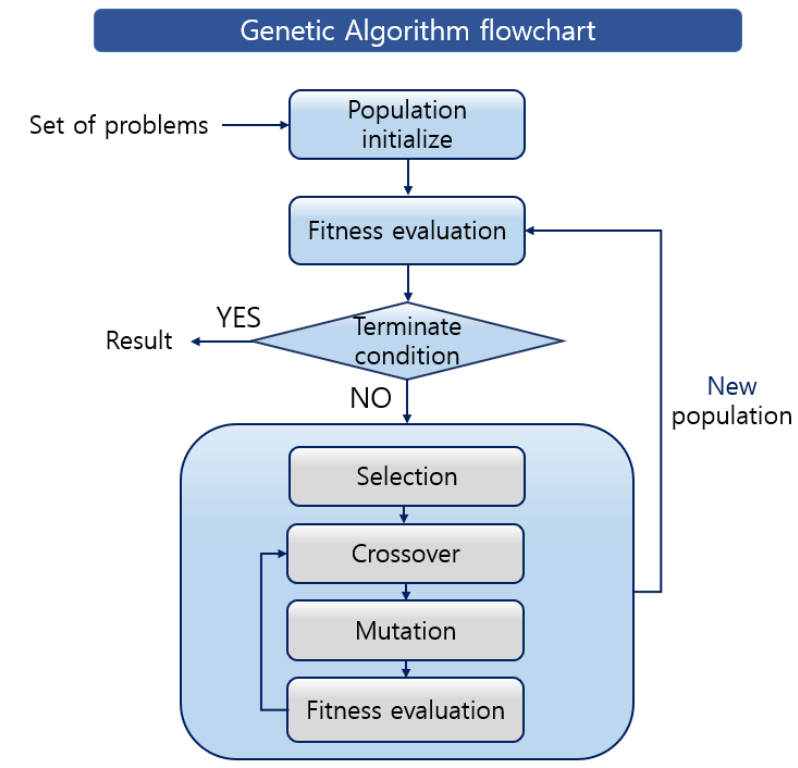
Figure 12. Schematic of genetic algorithm.